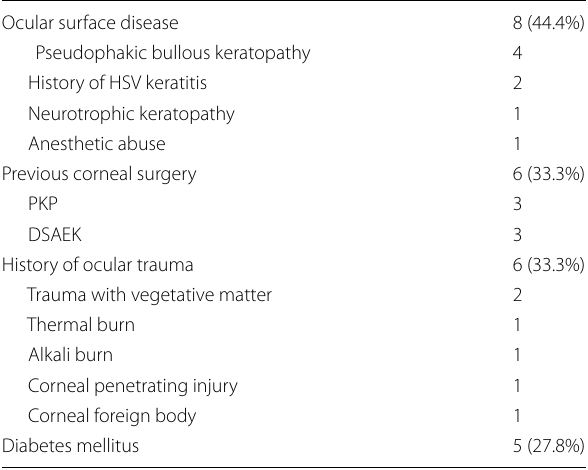
Table 1 Predisposing factors for development of